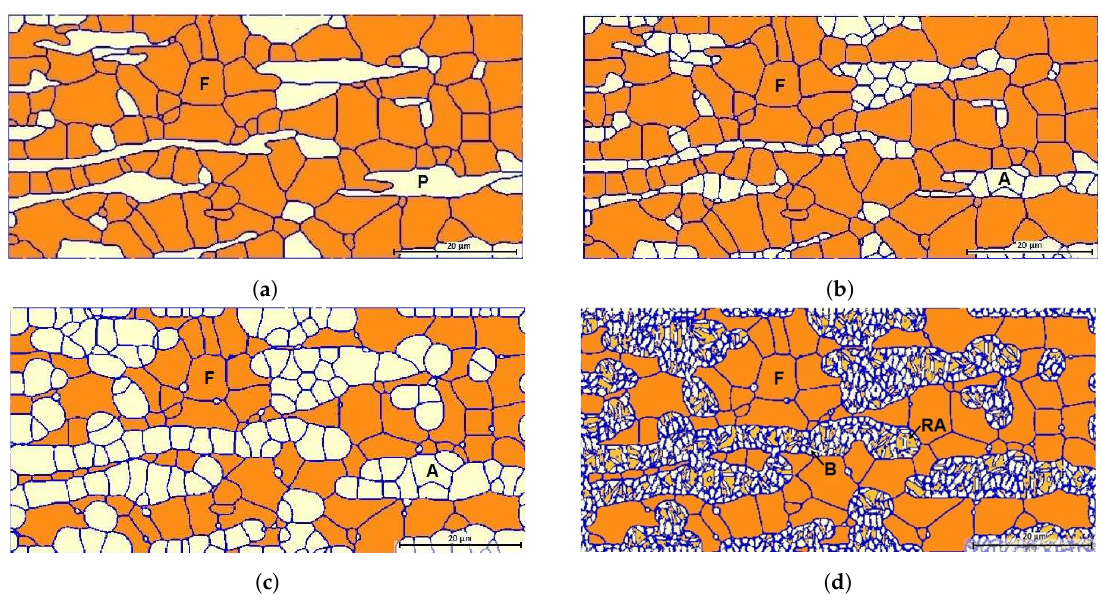
Figure 1. Microstructures ( a ) at the beginning of the intercritical annealing, ( b ) after the complete dissolution of pearlite, ( c ) at the end of the intercritical annealing, and ( d ) at the end of the isothermal bainitic treatment. Symbols P , F , and A denote pearlite, ferrite, and austenite grains, whereas RA and B correspond to retained austenite and bainitic